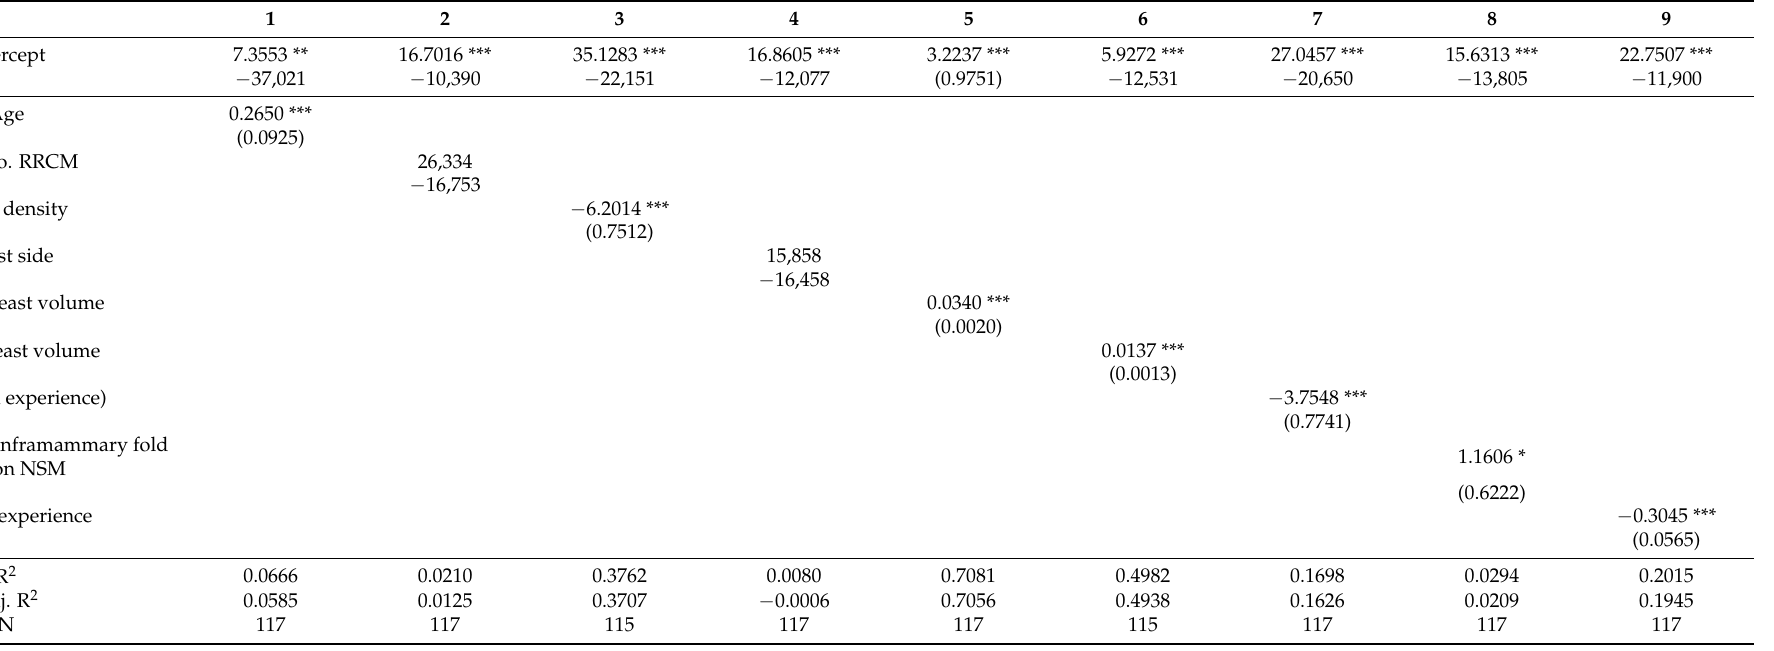
Table 5. Univariate regression—residual glandular tissue